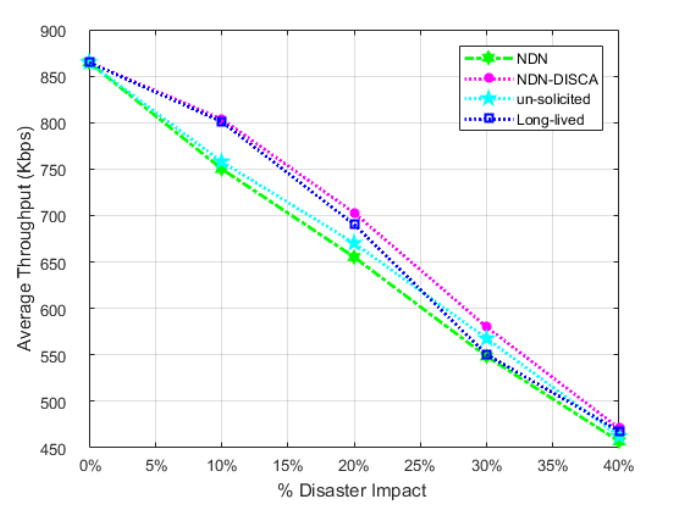
Figure 9. Average Throughput w.r.t Fire Disaster Affected SL-1 in